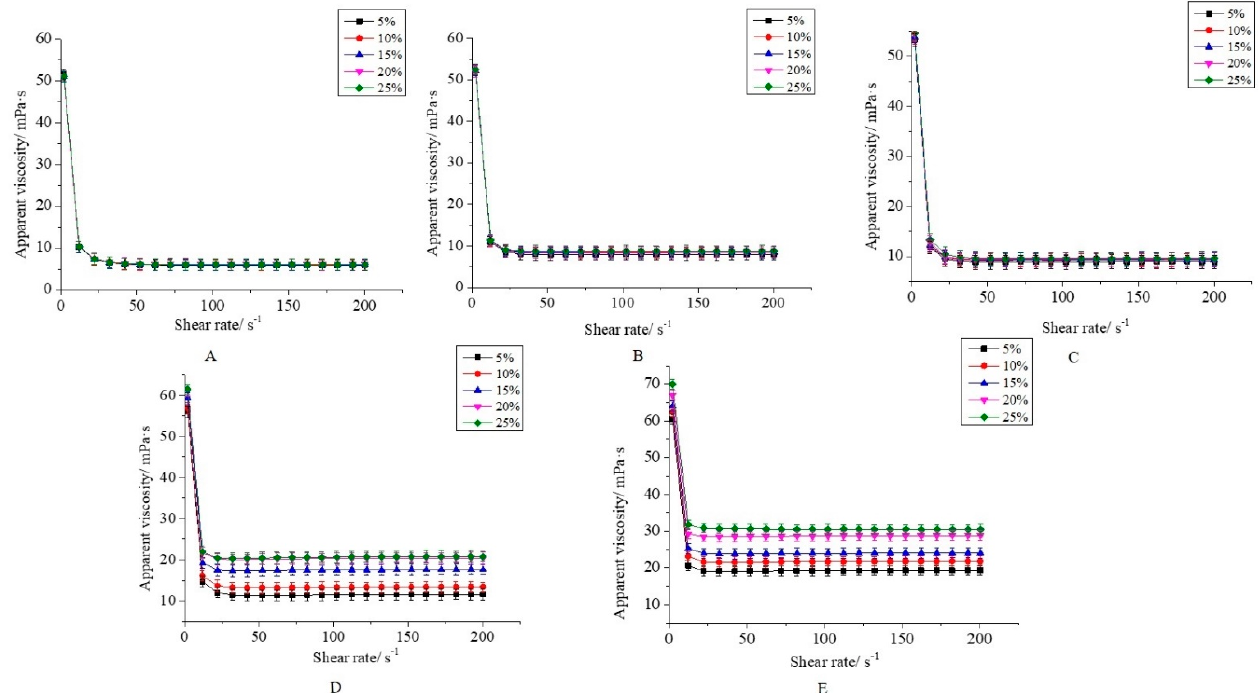
Figure 3. Apparent viscosity of S/O/W emulsions at different concentrations of NaCas and different proportions of S/O phase determined by rotation rheometer. ( A ) 2 wt% NaCas; ( B ) 4 wt% NaCas; ( C ) 6 wt% NaCas; ( D ) 8 wt% NaCas; ( E ) 10 wt% NaCas).